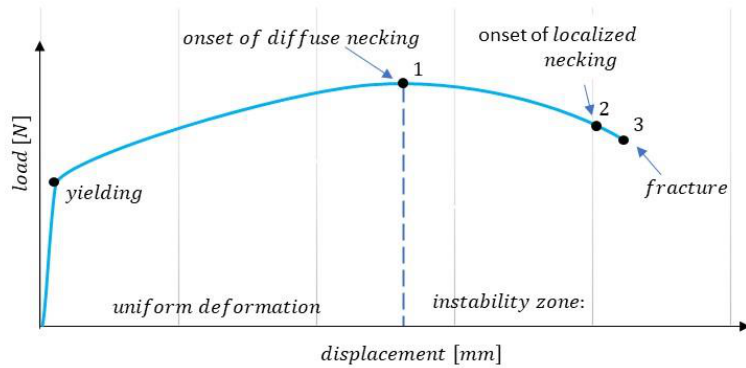
Figure 2. Load – displacement curve illustrating phases of the tension test. Figure 2. Load–displacement curve illustrating phases of the tension